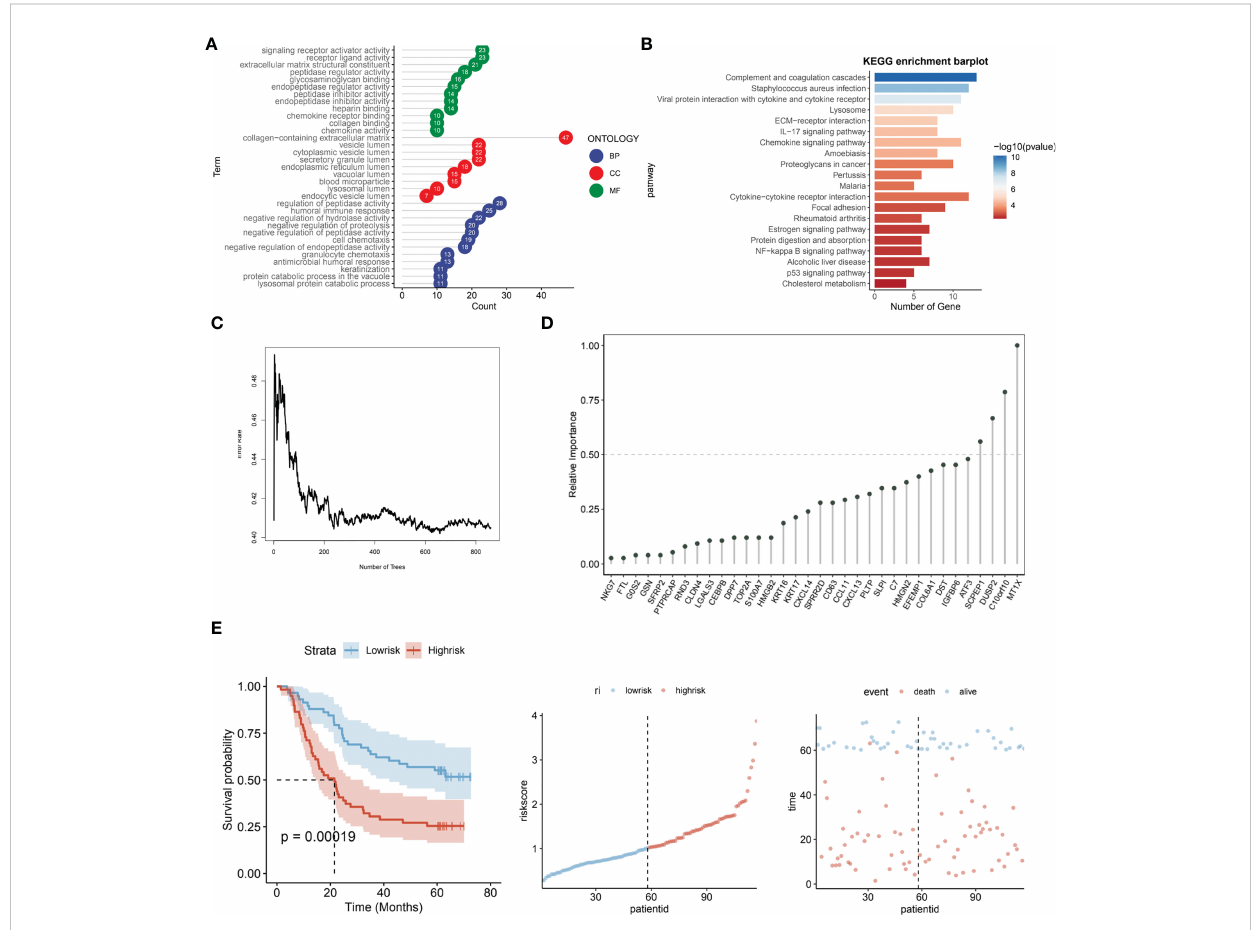
FIGURE 4 Prognostic risk modeling and functional enrichment analysis of lysosomal pathway-related transcriptomics in ESCC. (A) GO analysis revealed that DEG associated with lysosomal expression was mainly enriched in signaling receptor activator activity,receptor ligand activity,extracellular matrix structural constituent -peptidase regulator activity,glycosaminoglycan binding,endopeptidase regulator activity; (B) KEGG enrichment barplot showed that lysosomal DEG-related pathways were mainly enriched in omplement and coagulation cascades, Staphylococcus aureus infection, Viral protein interaction with cytokine and cytokine receptor enriched in; (C) Transcriptomic risk model construction for lysosomal-DEG by decision trees constructed from random forest; (D) Histogram analysis of the relative importance of lysosomal-DEG models in the fi nal transcriptomic prognostic risk model, with MT1X possessing the highest prognostic-related importance; (E) Assessment of the predictive power of the constructed lysosomal pathway-related transcriptomic prognostic risk models, from left to right. Kaplan-Meire curves for the lysosome-associated prognostic risk model, distribution of risk scores, and scatter plots of prognostic survival times for patients with different risk